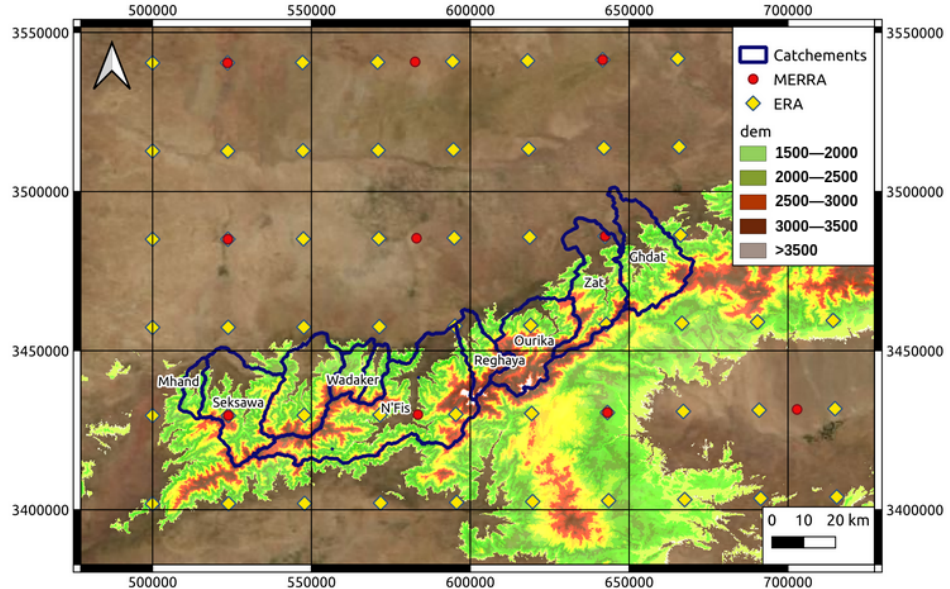
Figure 1. Map of the study area map showing MERRA-2 (red dots) and ERA5 (yellow stars) centroid coordinates. Blue lines indicate the boundaries of each sub-catchment. A DEM of areas where elevations are higher than 1500 m.a.s.l, where snowfall generally occur, is also